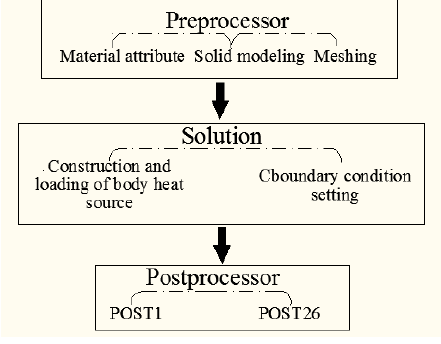
Figure 10. Simulation analysis process. Table 2. Physical performance parameters of polymethyl methacrylate (PMMA).